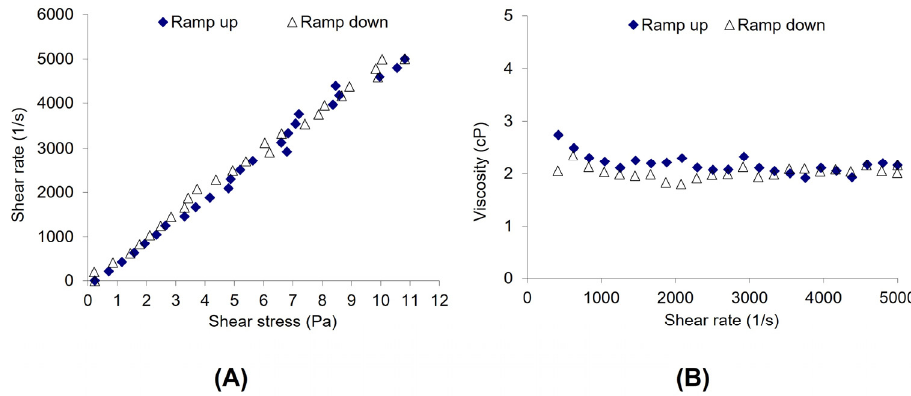
Figure 4. Rheology profiles of ganciclovir/HYA0.1 ED plotted between shear stress vs. shear rate ( A ) and shear rate vs. viscosity ( B ). The viscosity and shear stress were recorded while the shear rate was increasing (blue diamond) and decreasing (blank triangle) over the range of 10–5000 s − 1 .